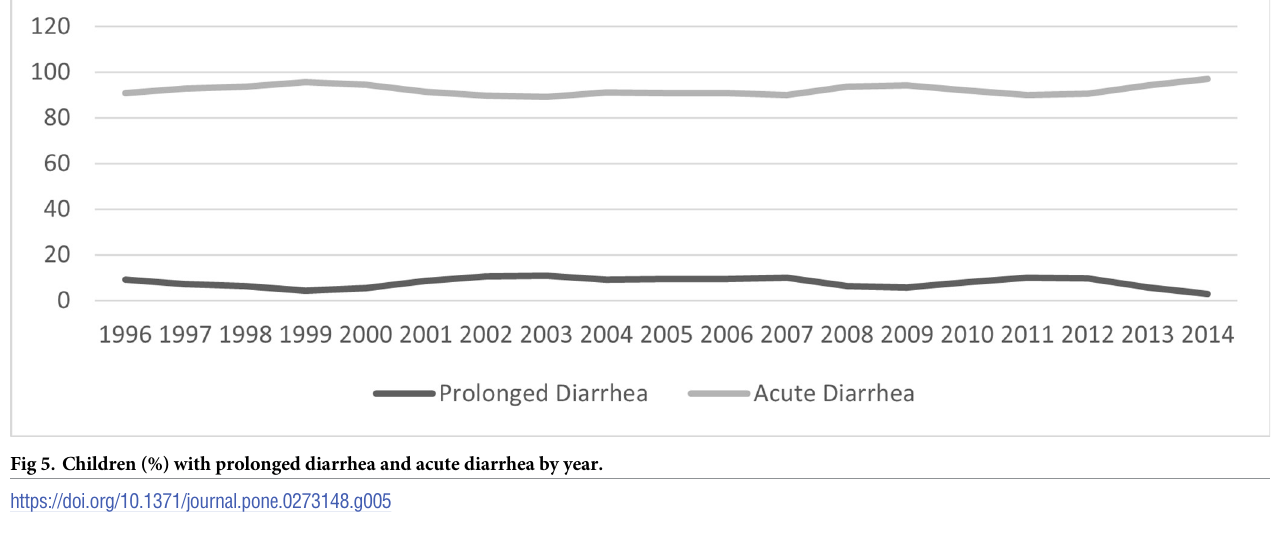
Fig 5. Children (%) with prolonged diarrhea and acute diarrhea by year.